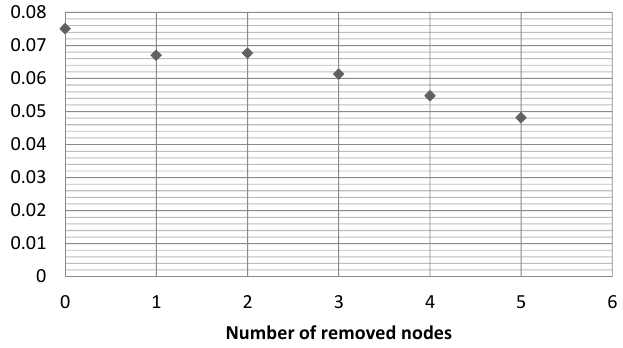
Figure 19. The change of the clustering coefficient.